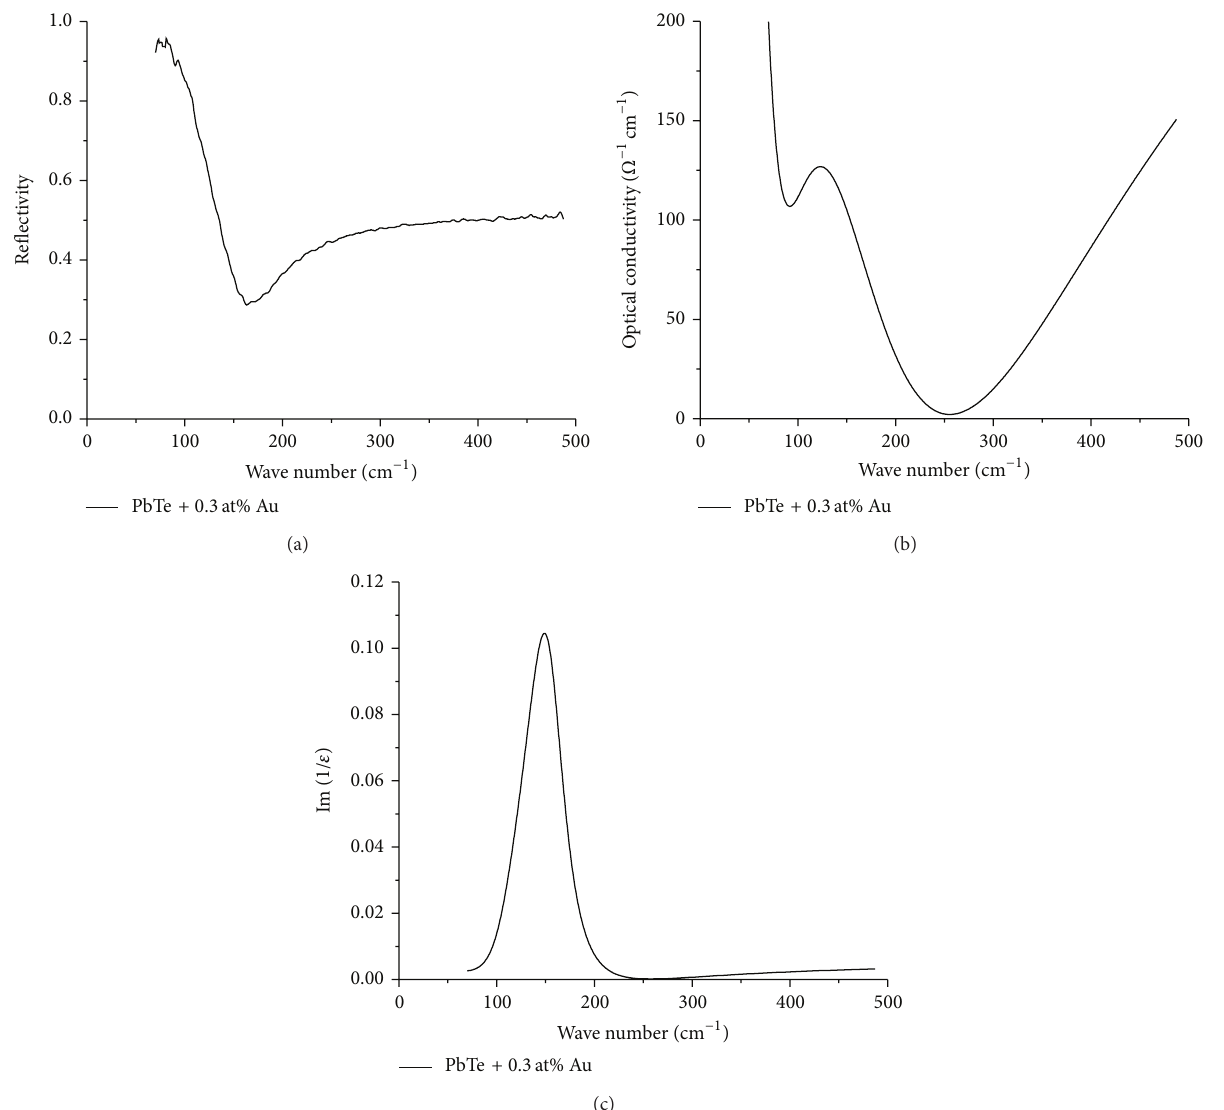
Figure 8: (a) Optical reflectivity diagram for PbTe doped with 0.3 at% Au, (b) its optical conductivity, and (c) reciprocal value of imaginary part of dielectric constant [Im (1/𝜀)